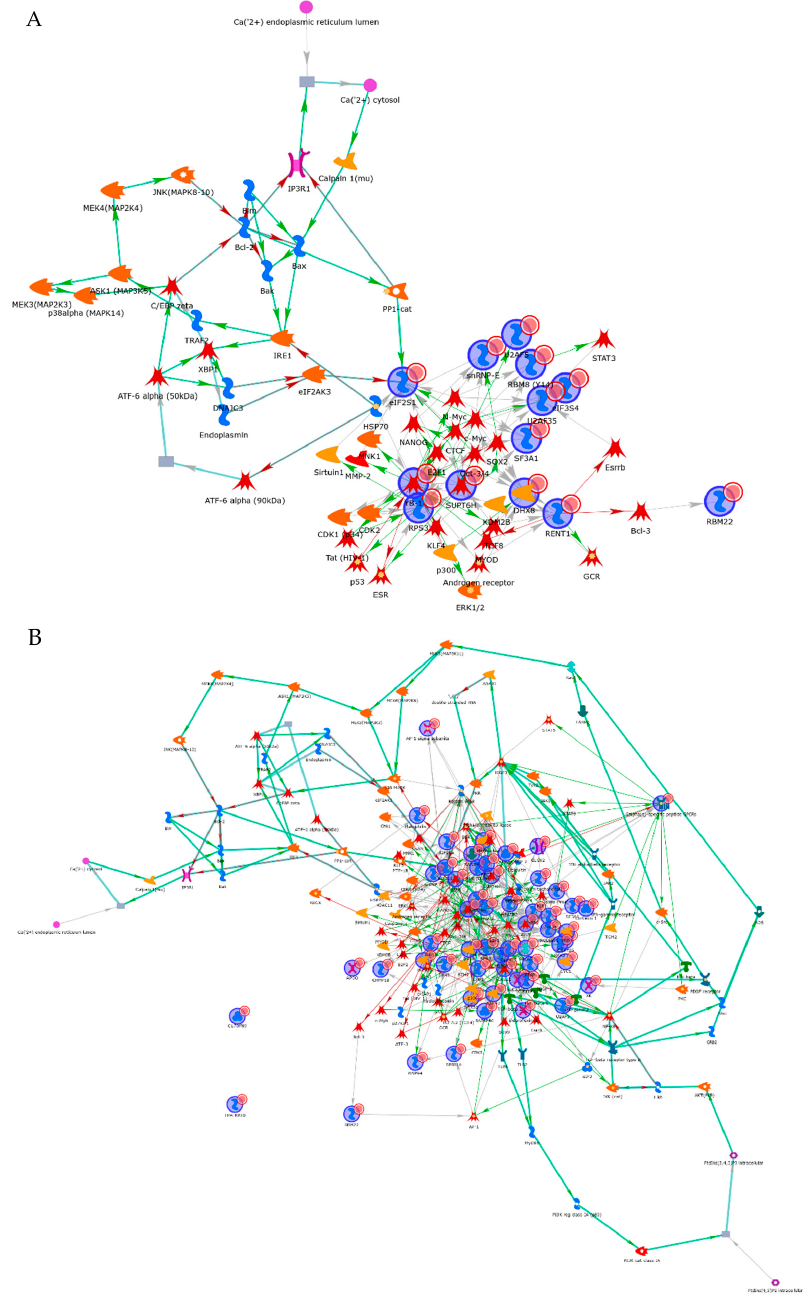
Figure 6. The network analysis of identified cancer-related mRNAs and aberrantly expressed mRNAs in cancer cells. The expression of identified cancer-related RBPs was regulated by the classical cell survival signal pathway ( A ). mRNAs that are overexpressed in cancer cells were shown to be regulated by the identified cancer-related RBPs in cancerous cells ( B ).